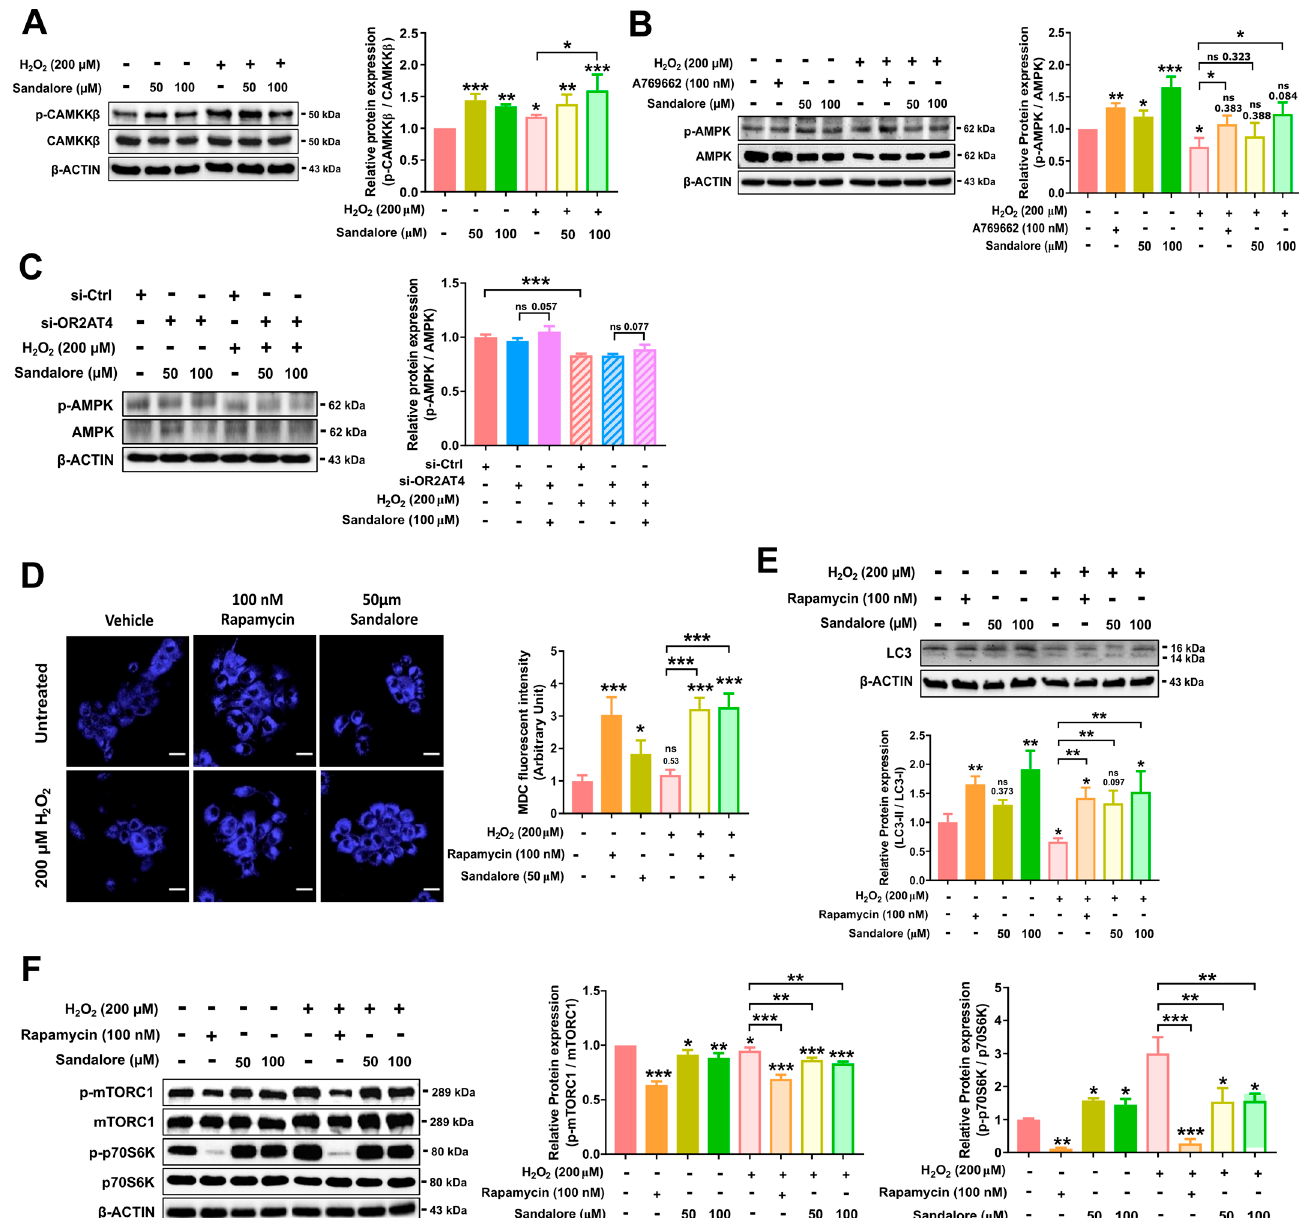
Figure 5. OR2AT4 activation by sandalore mediates the CAMKK β /AMPK/mTORC1/autophagy axis. Expression of total and phosphorylated ( A ) CAMKK β and ( B ) AMPK by immunoblot analysis. ( C ) Representative images of MDC-stained HaCaT cells. Scale bar, 20 µm (left panel). Quantification of the MDC fluorescence intensity in HaCaT cells (right panel). Fluorescence was quantified using the VICTOR ™ X Multilabel Plate Reader. ( D ) The expression of LC3I and LC3II by immunoblot analysis (left panel). Bar graphs represent the ratio of the LC3II to LC3I within each sample (right panel). ( E ) Expression of the total and phosphorylated mTORC1 and 70S6K by immunoblot analysis. ( F ) Expression of the total and phosphorylated AMPK in the OR2AT4-knockdown HaCaT cells. The relative protein expression of p-CAMKK β /CAMMK β , p-AMPK/AMPK, p-mTORC1/TORC1, and p-p70S6K/p70S6K were analyzed using ImageLab software. Data are means ± SEM. * p < 0.05, ** p <0.01, and *** p < 0.001. Student’s t -test was performed for comparisons between groups.